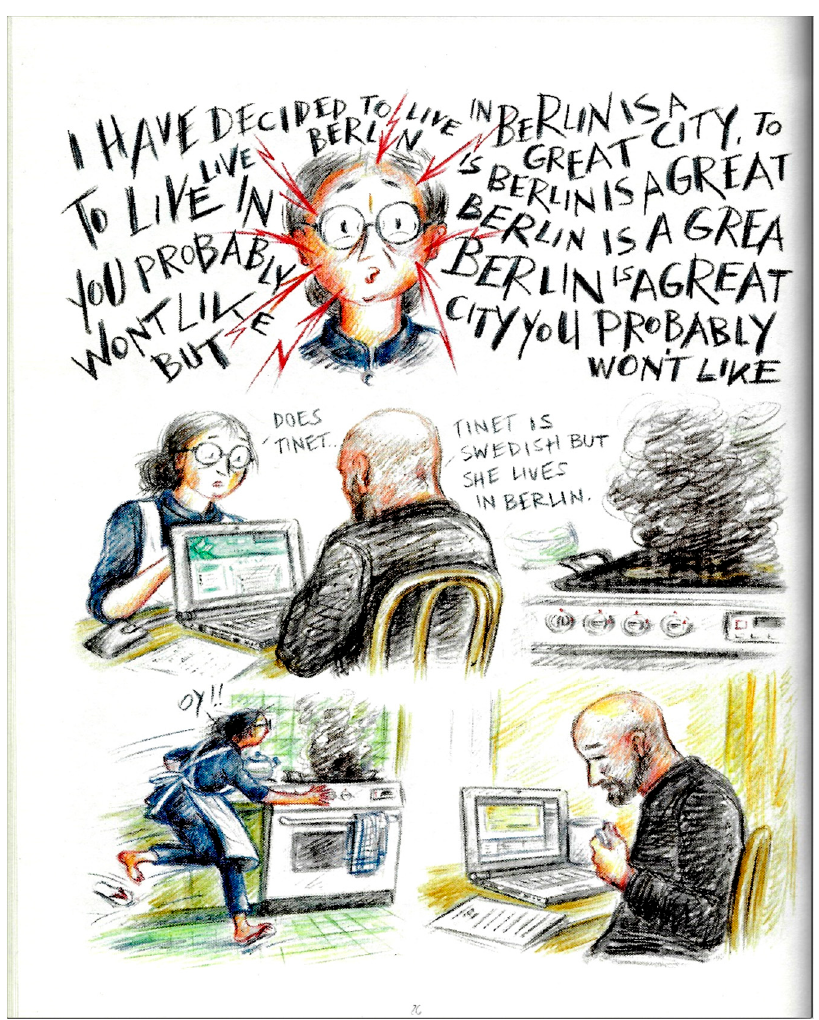
Figure 6. Letting It Go (Katin 2013). Reproduced by permission of Miriam Katin.